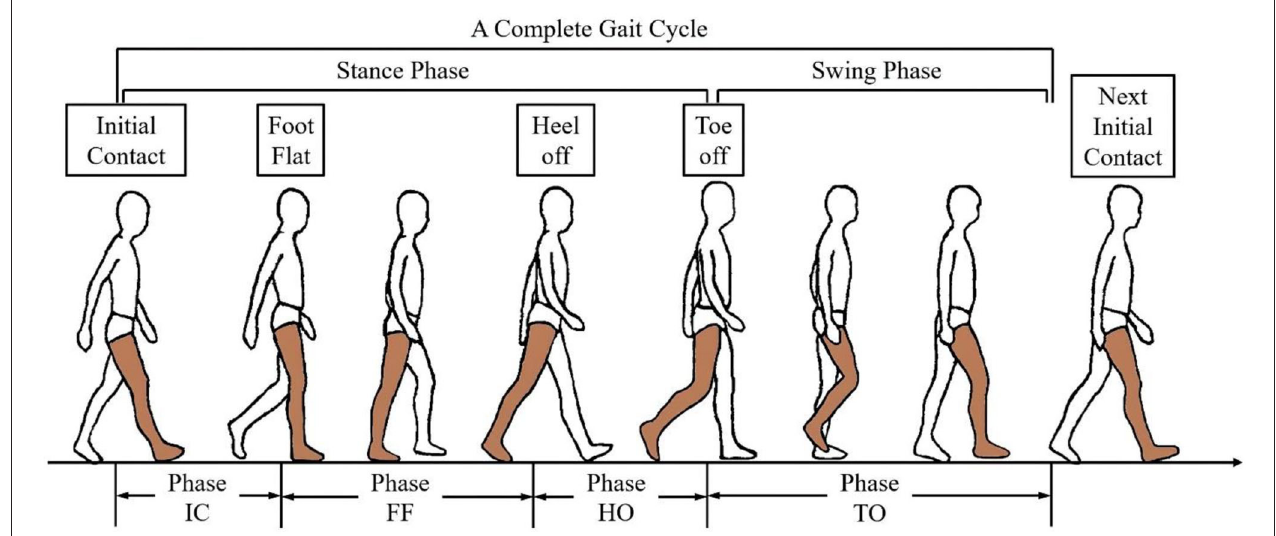
FIGURE 1 | The gait phase definition in a gait